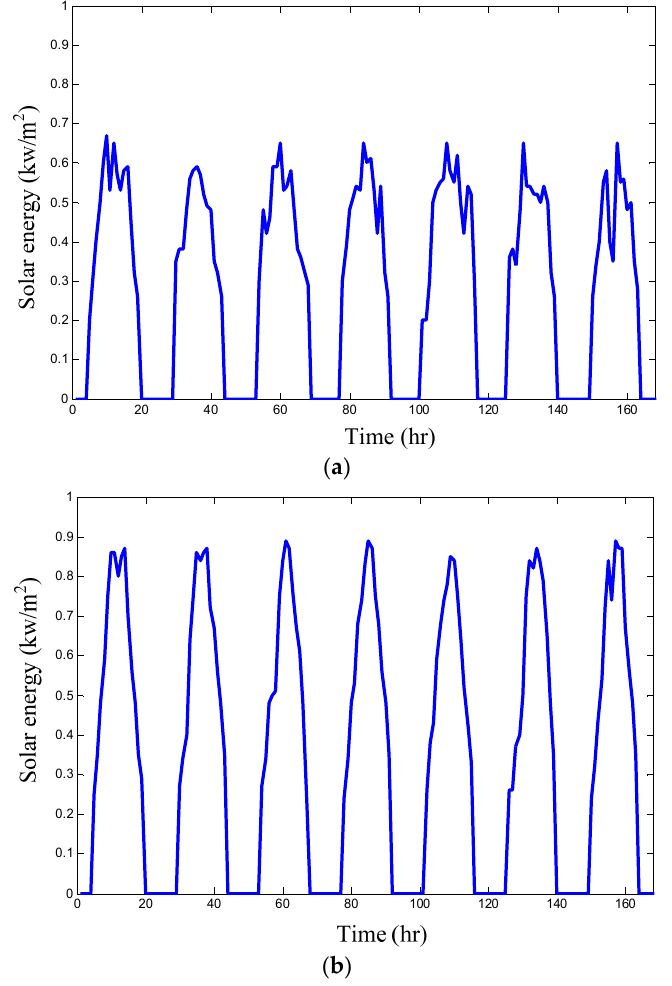
Figure 7. The curves of the typical solar illuminance ( a ) winter; ( b ) summer.